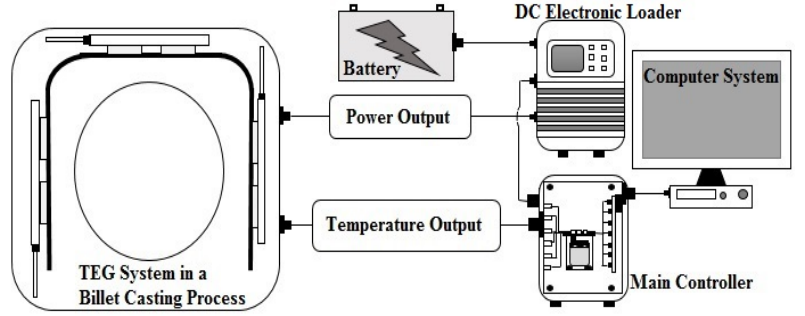
Figure 1. Schematic view of the experimental test facility.